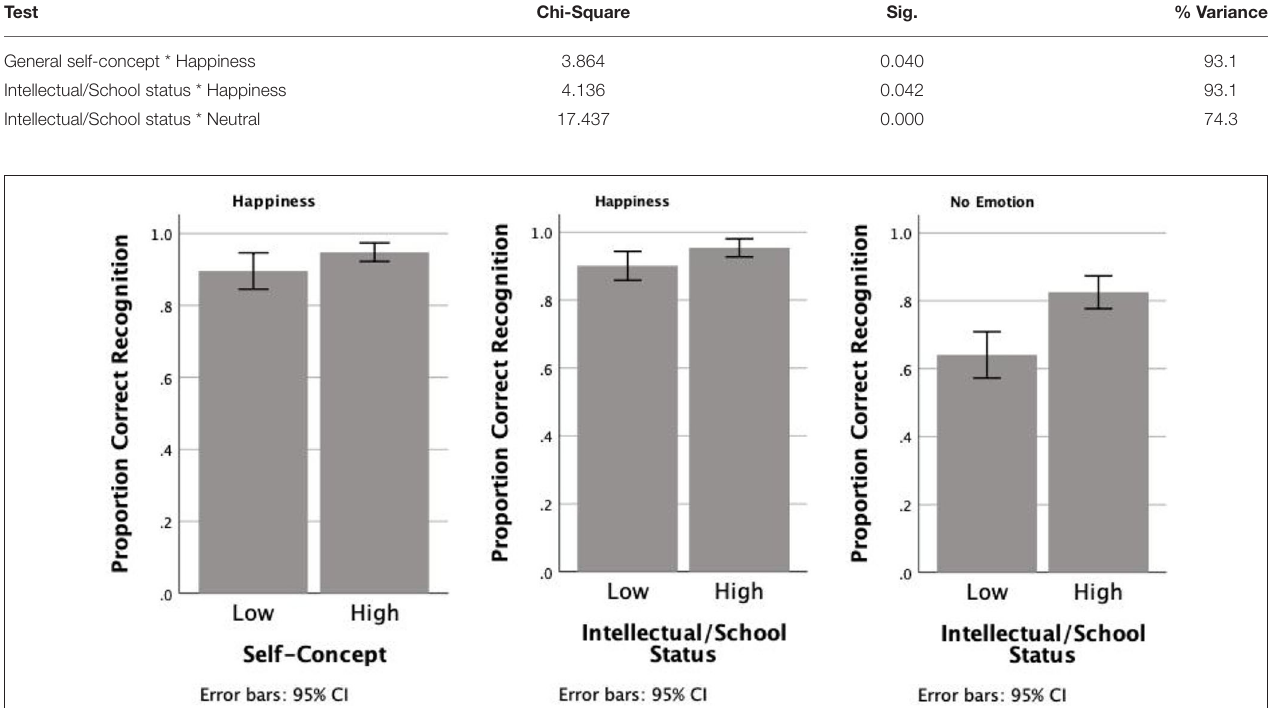
FIGURE 5 | Proportion of correct emotion recognition by low- and high-self-concept children in the identification of happiness and no